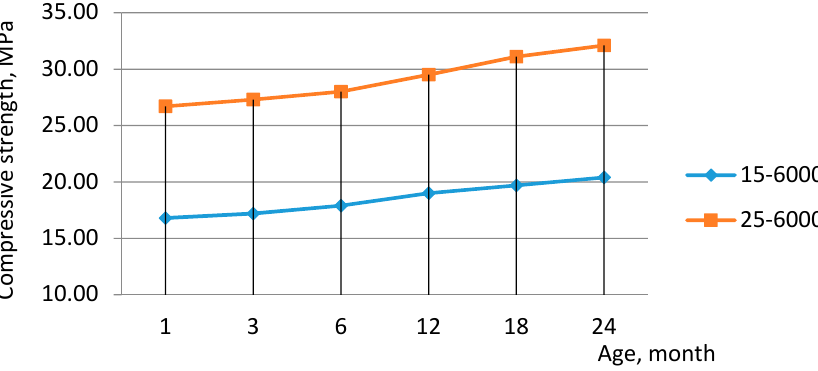
Figure 3. Evolution of compressive strength in the period of 1–24 months.